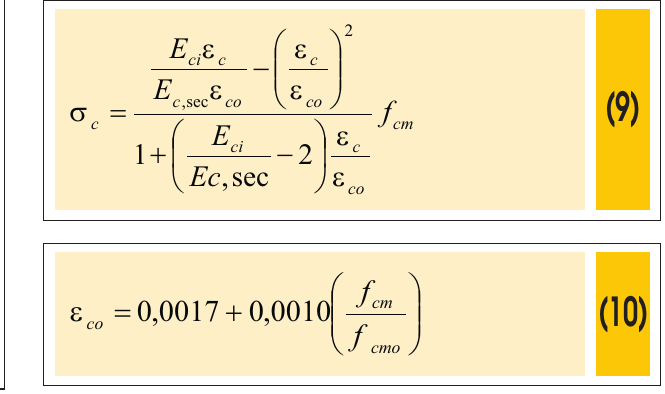
Figure 4 – Diagram (  s  - e ) concrete